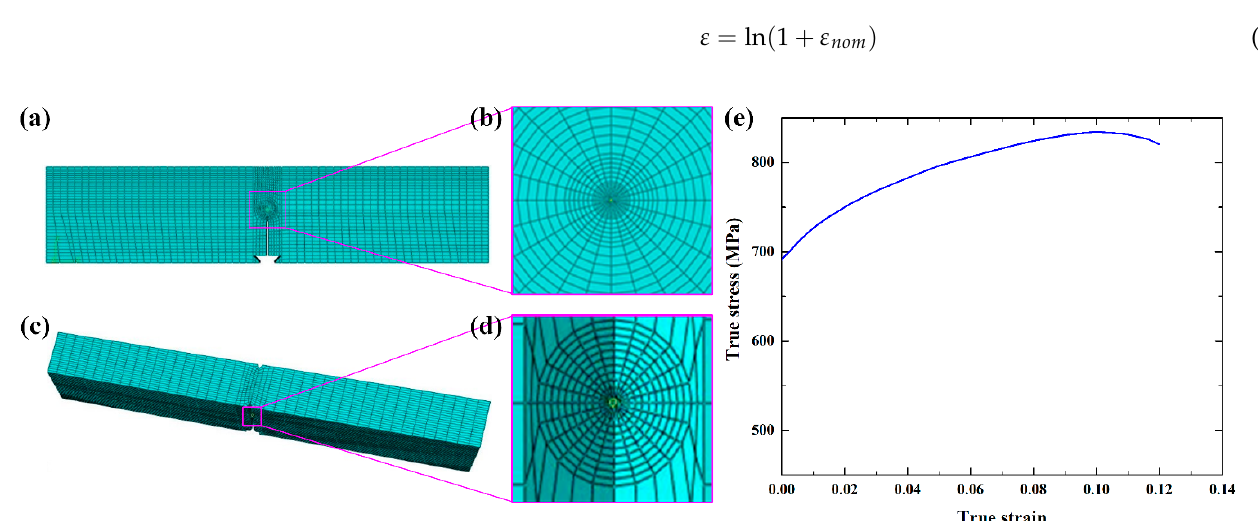
Figure 5. Finite element models of specimens: ( a ) overall model without side grooves; ( b ) crack tip of specimen without side grooves; ( c ) overall model with side grooves; ( d ) crack tip of specimen with side grooves; ( e ) relationship between true stress σ and true strain ε calculated by Equations (8) and (9). Table 5. Elastoplastic material parameters in the finite element model.